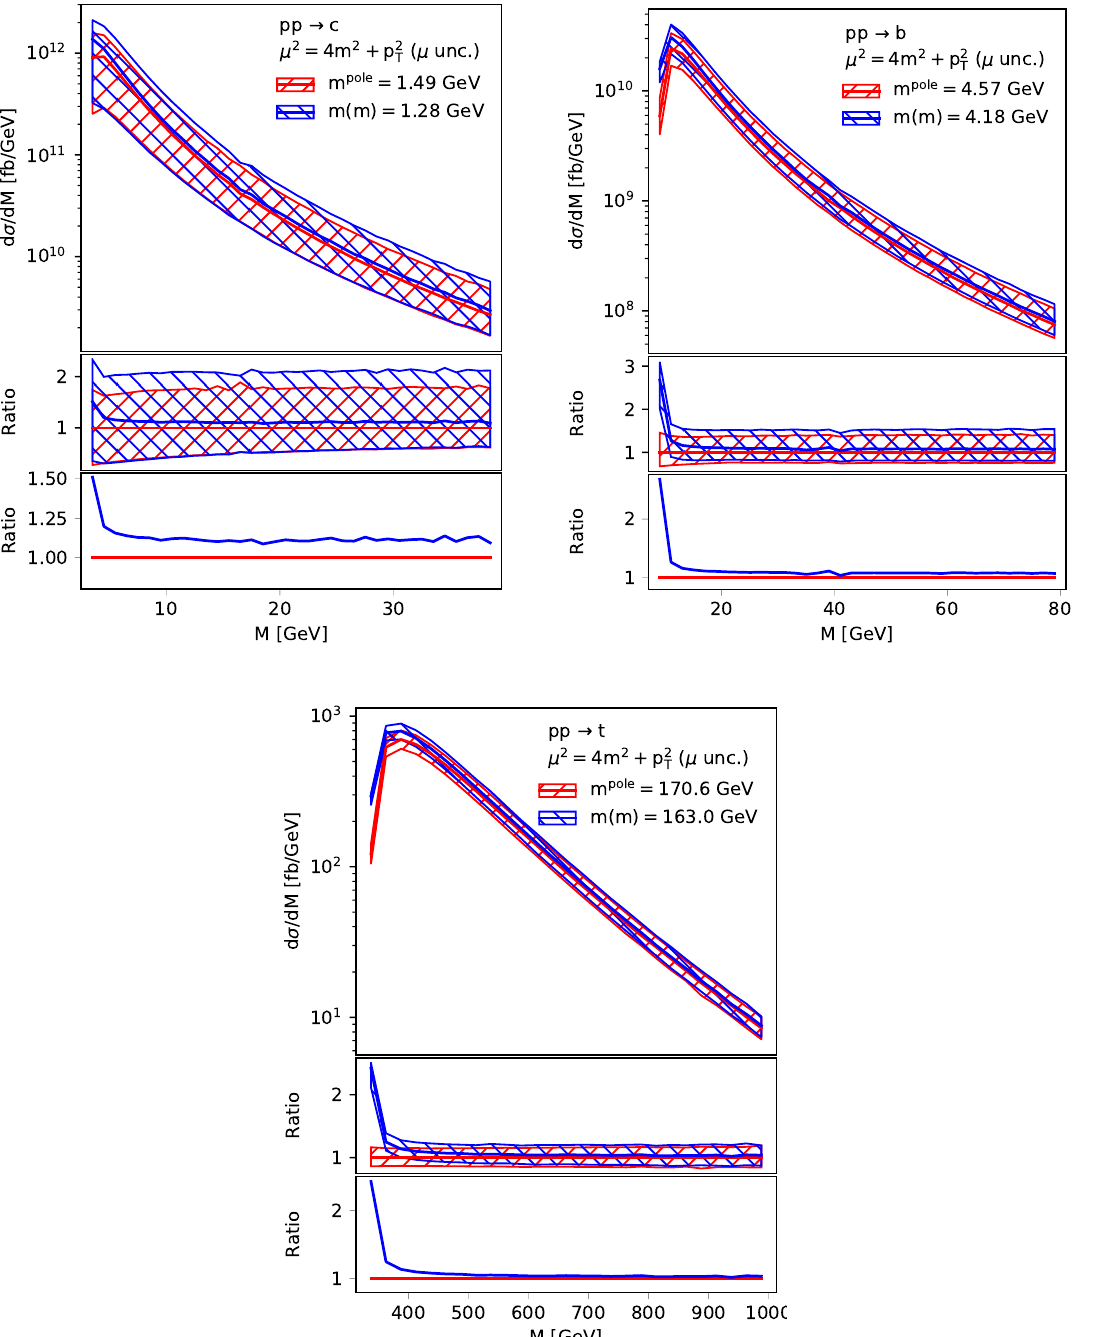
√ Figure 12 . The NLO differential cross-sections at the LHC ( s = 7 TeV) for charm (upper left), bottom (upper right) and top (lower) hadro-production with their scale uncertainties as a function of the invariant mass M of the heavy-quark pair in the pole and MS mass schemes. The lower Q ¯ Q panels display the theoretical predictions normalized to the central values obtained in the pole mass